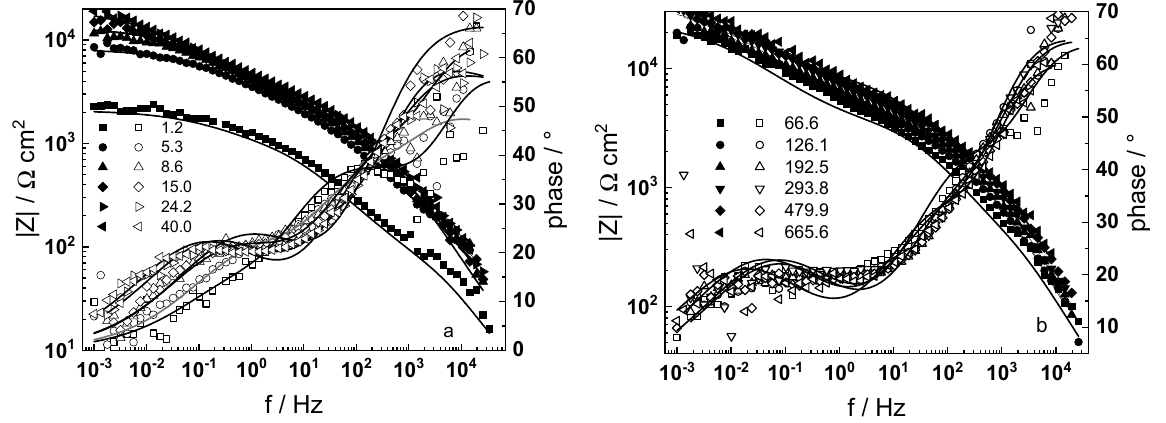
Figure 1. Electrochemical impedance spectra of zirconium alloy in WWER coolant without LiOH at 300 °C depending on the oxidation time. Left ordinate-impedance magnitude (full symbols) and phase shift (open symbols) vs. frequency. Points-experimental data, solid lines-best-fit calculation. The legend gives oxidation time in h.